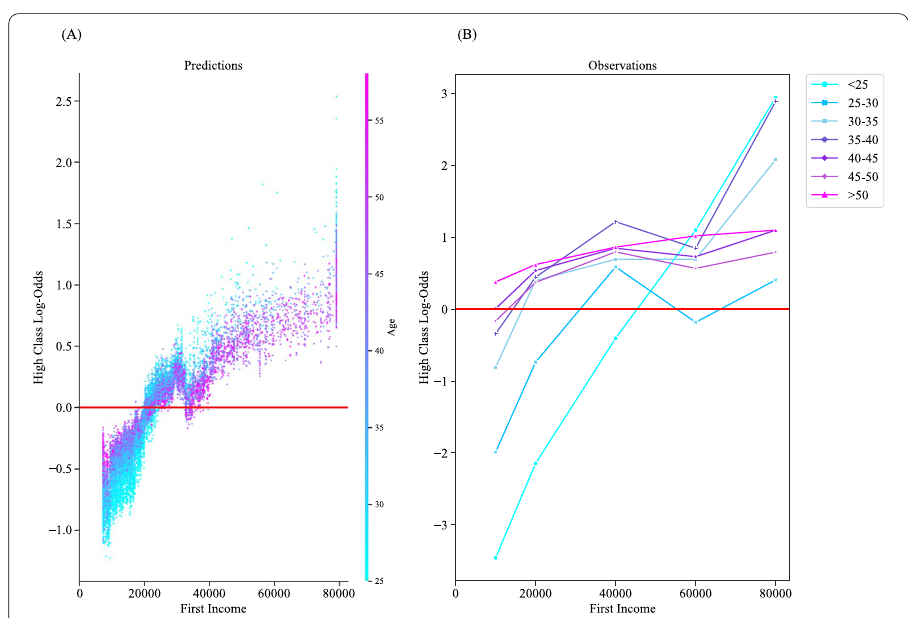
Fig. 15 First Income and Age SHAP dependency plot of the gradient boosting model, where A are the predictions and B are the real